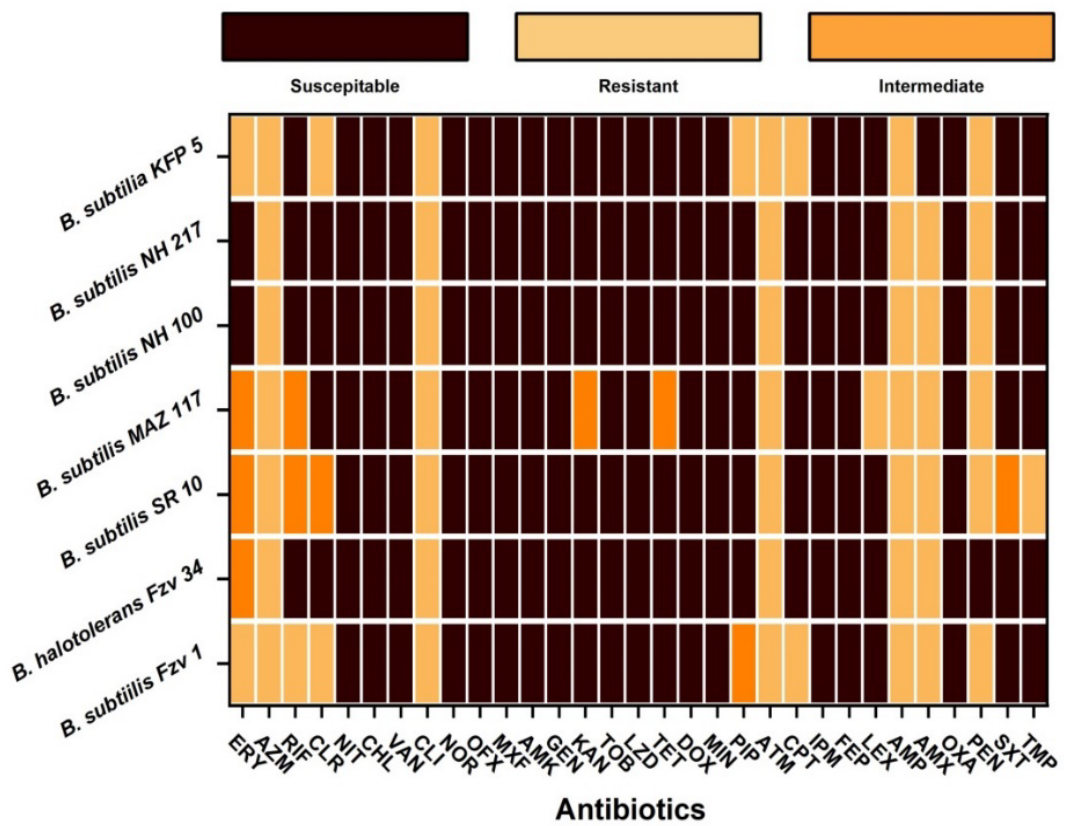
Figure 1. Prevalence of antimicrobial resistance in the Bacillus spp. ERY, Erythromycin; AZM,